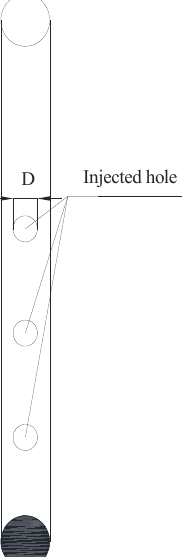
Figure 5. Grout pore distribution diagram of grouting pipe.